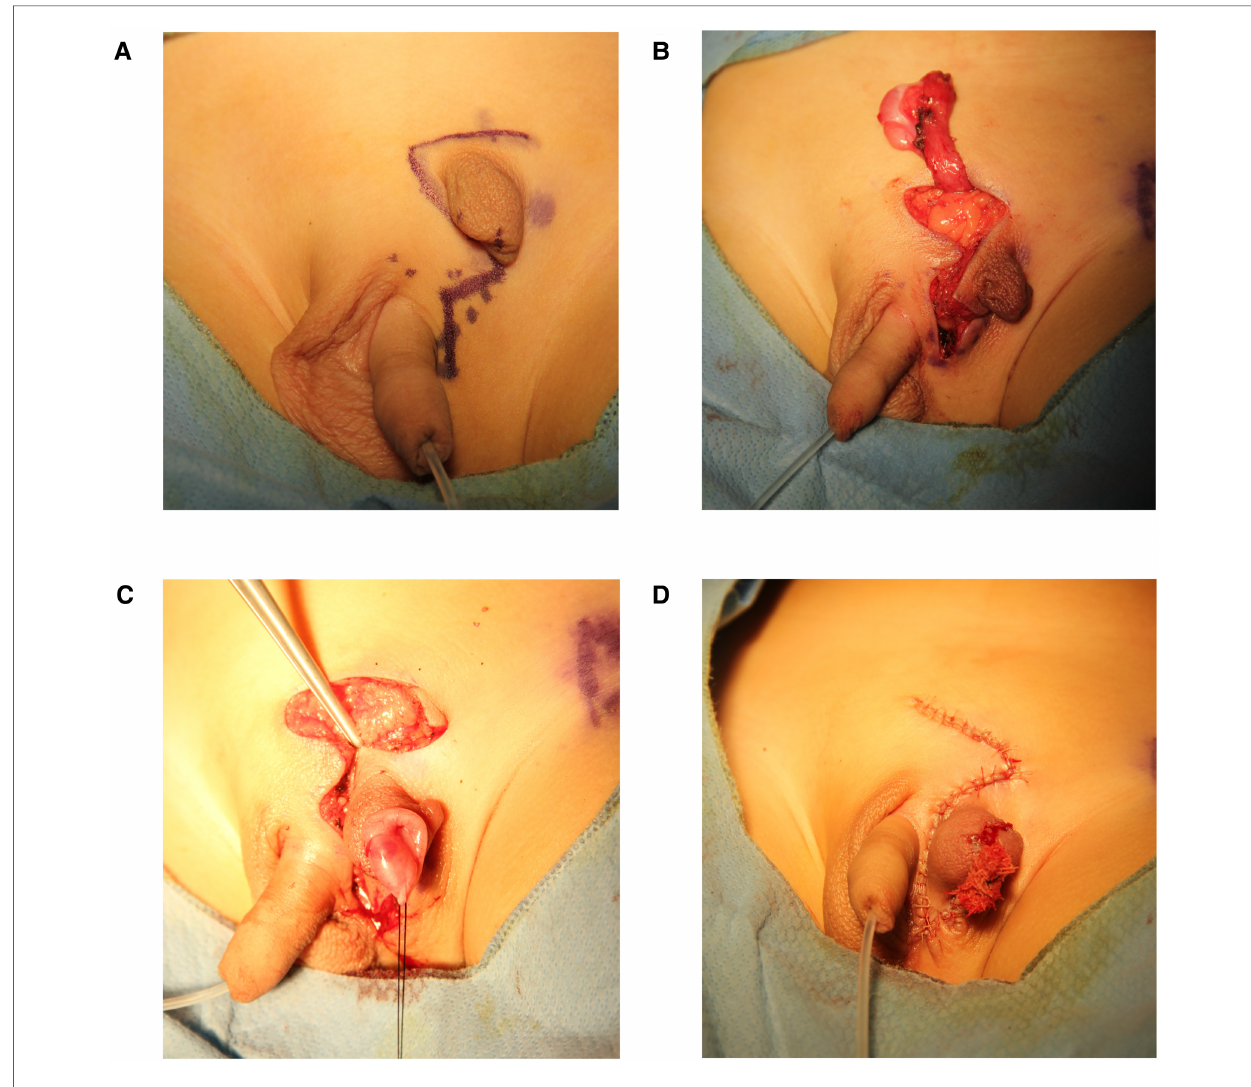
FIGURE 3 (A-D) Photographs of the surgery